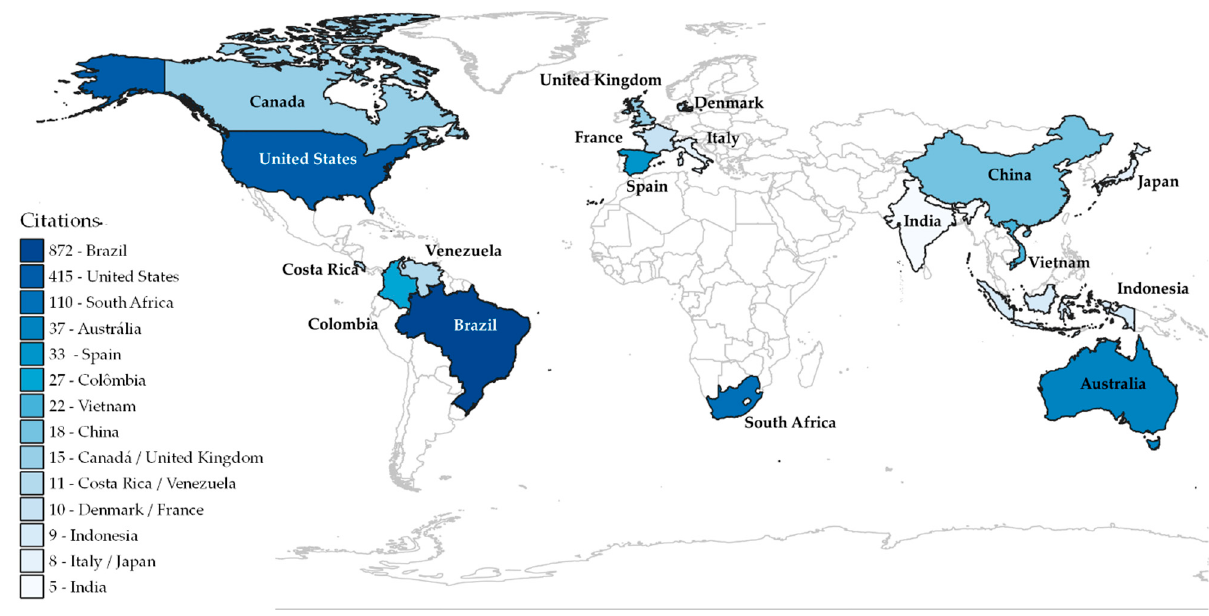
Figure 4. Number of citations by Country.